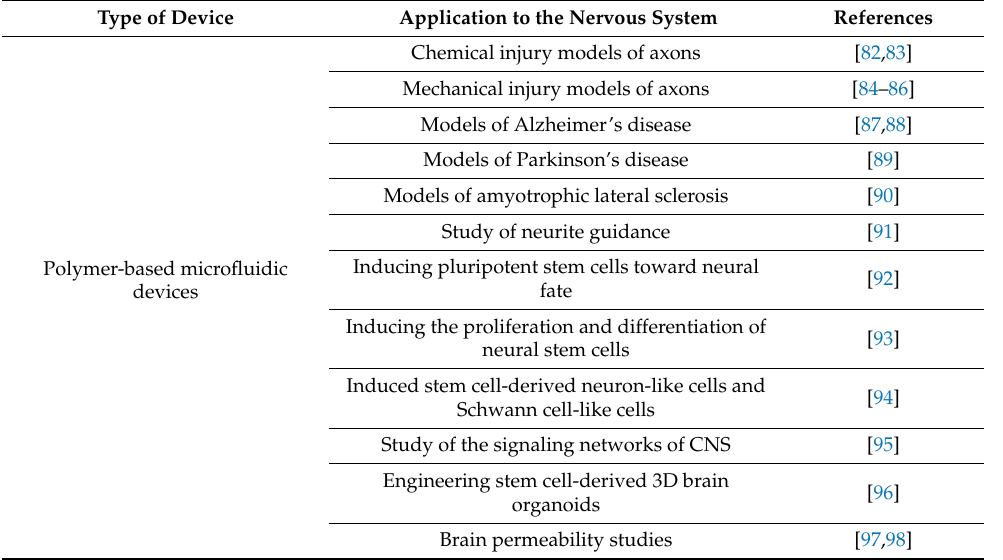
Table 1. Summary of the different microfluidic devices and their applications to the nervous system. Abbreviations: 3D, three-dimensional; CNS, central nervous system; PNI, peripheral nerve